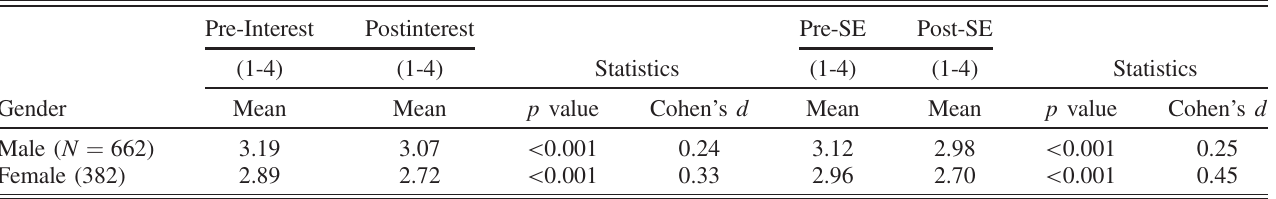
TABLE VII. Paired-sample t test for matched pairs (matched pair refers to students who took both pre- and postsurveys) of pre- and post-self-efficacy and interest for female and male